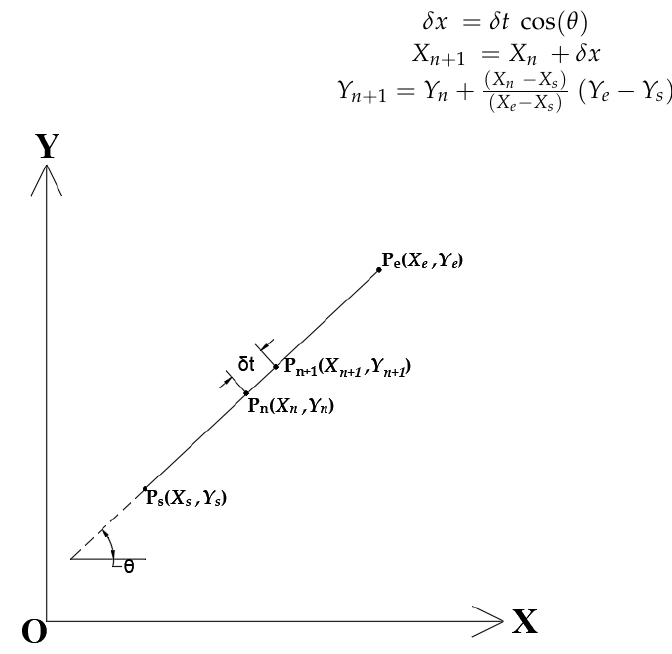
Figure 8. Linear interpolation.